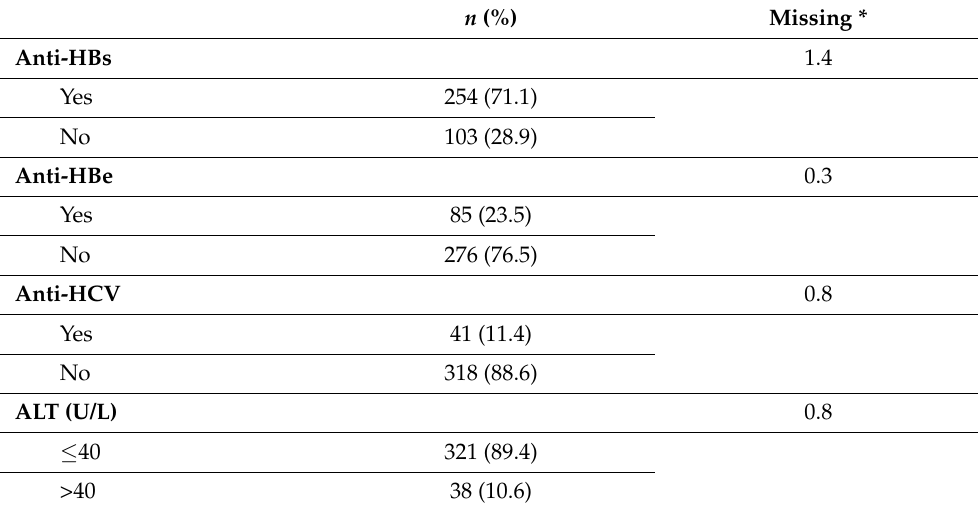
Table 2. Virological characteristics of patients with past HBV infection ( n =